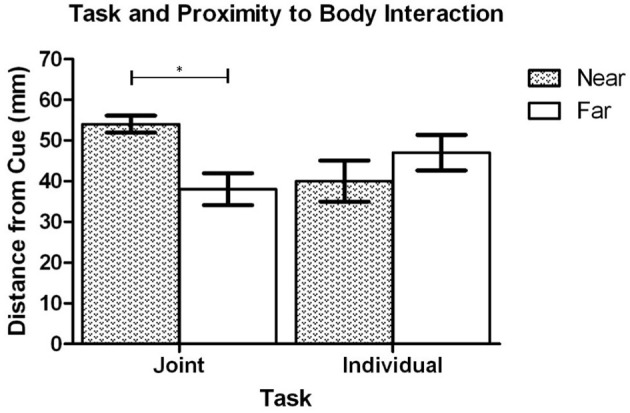
Experiment 2: Mean distance of the dowel to the cued location in Near and Far space during the Individual and Joint tasks. Error bars represent the standard error of the mean. The * indicates a statistically significant difference.